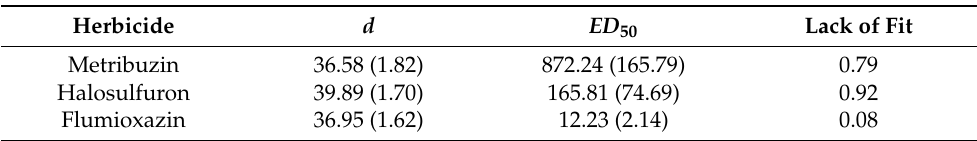
Table 3. Estimated sigmoidal parameters for metribuzin, halosulfuron and flumioxazin on potato. Standard errors in